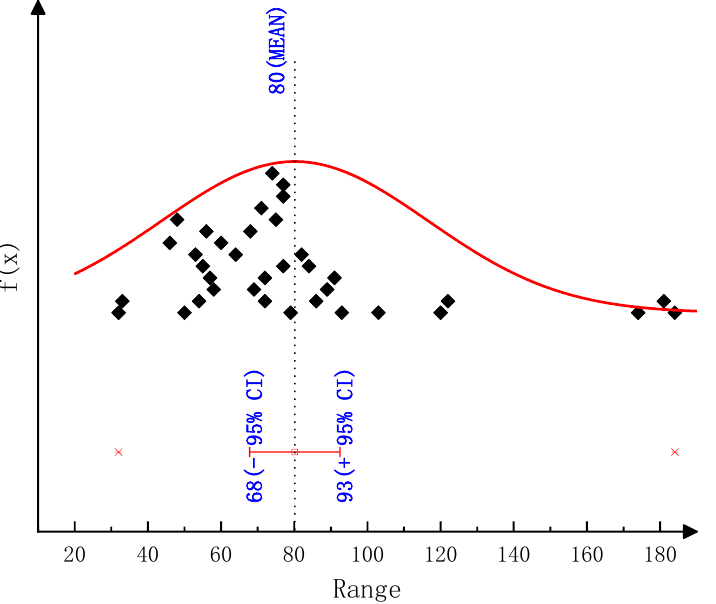
O of urea pyrolysis reaction.